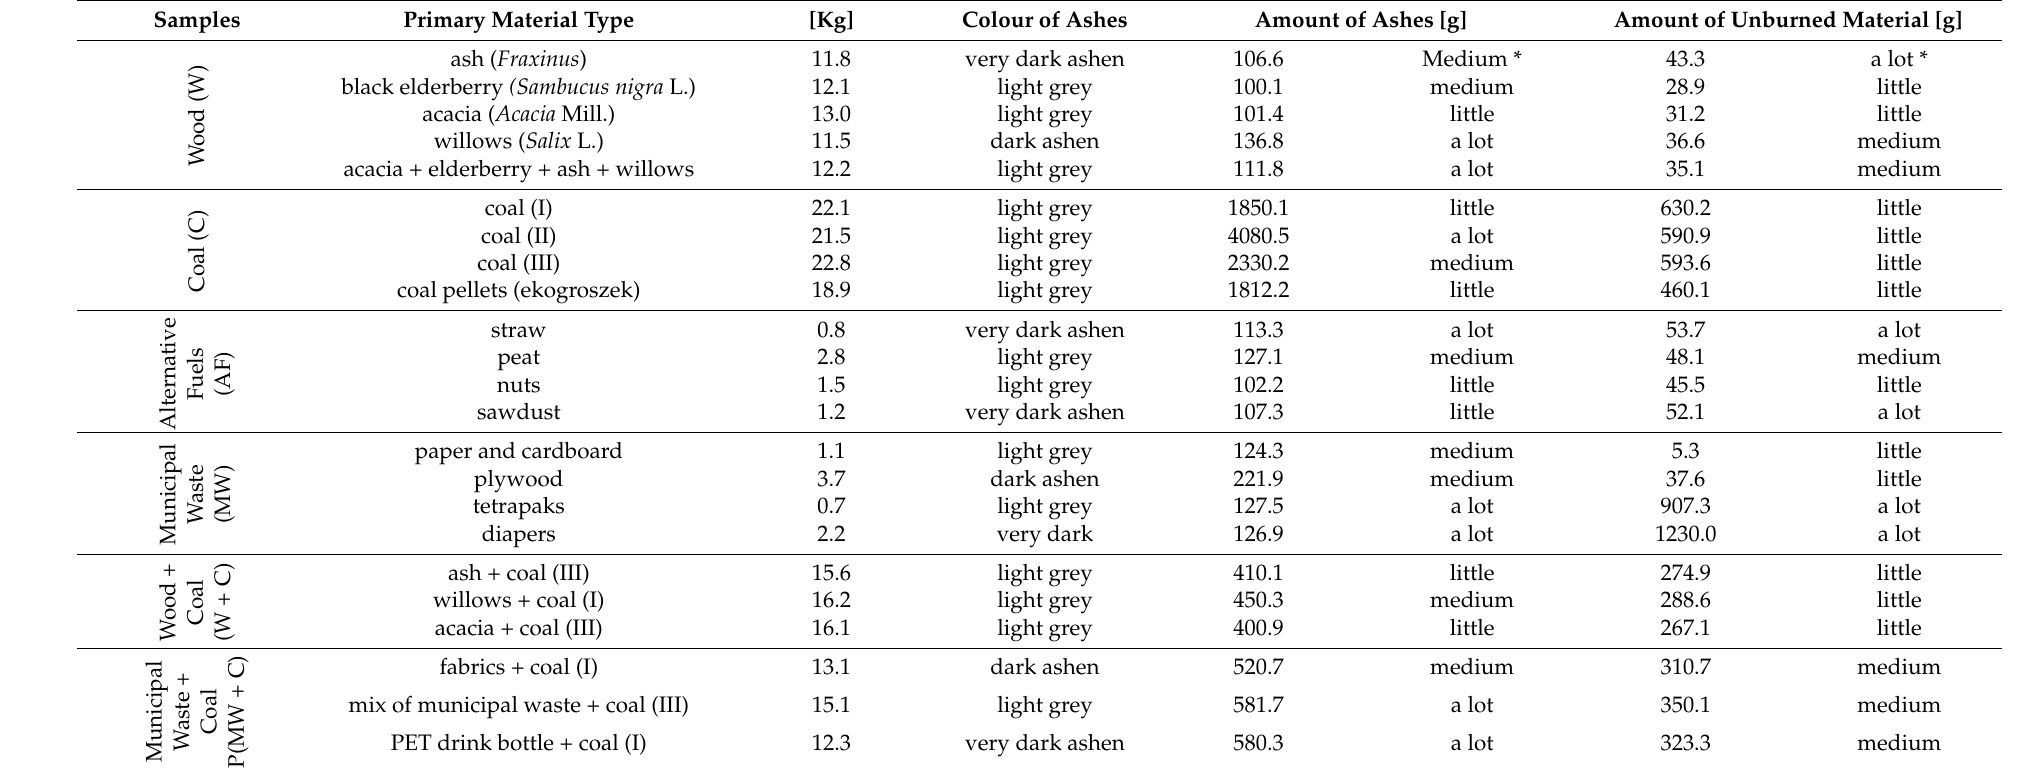
Table 1. Characteristics of